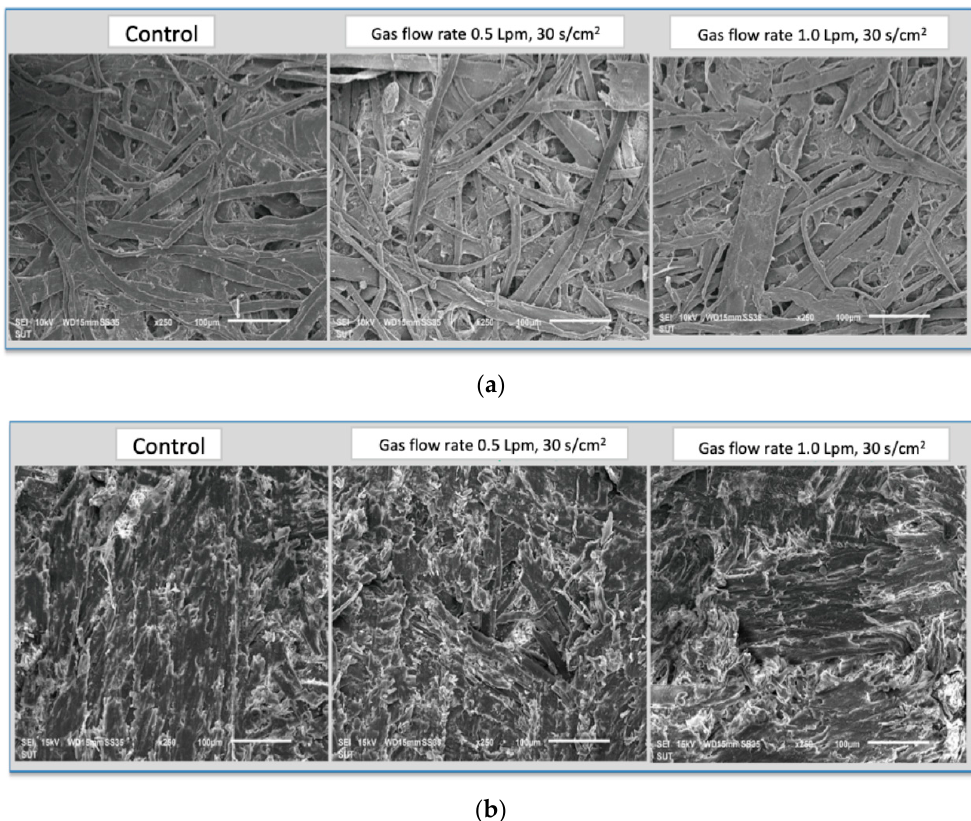
Figure 4. Scanning electron microscope (SEM) images of cardboard ( a ) and drawing board ( b ) after plasma treatment (magnification ×250).